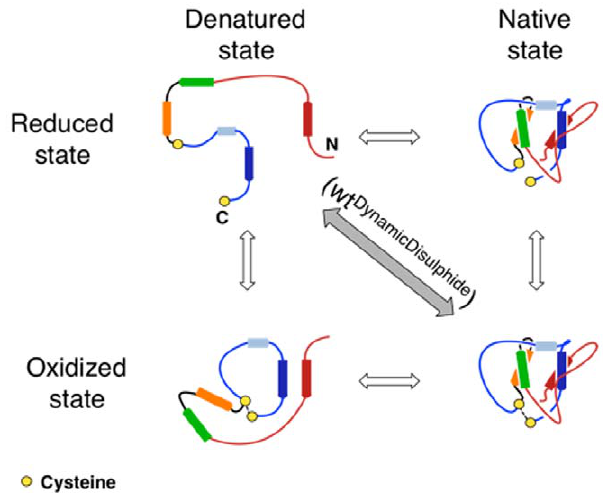
Figure 8. Cartoon of the different folded/unfolded states. The cartoon represents reduced and oxidized leptin, seen in the top- and bottom panel respectively. The left- and right panel shows the denatured and native state respectively. The grey colour indicates the intercon- version between two constructs as a result of the numerical simulation where the disulphide bond is continuously made and broken during simulation ( wt DynamicDisulphide ). Spontaneous reduction of the protein (grey pathway) is not observed